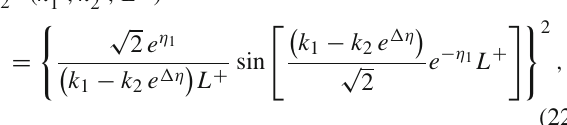
Fig. 6 Ratio of non-eikonal cross section with respect to the eikonal one both in the forward ( (cid:8)φ = 0) and the backward ( (cid:8)φ = π ) peaks and for η 1 = 0, k 1 = 1 GeV and k 2 = 1 . 2